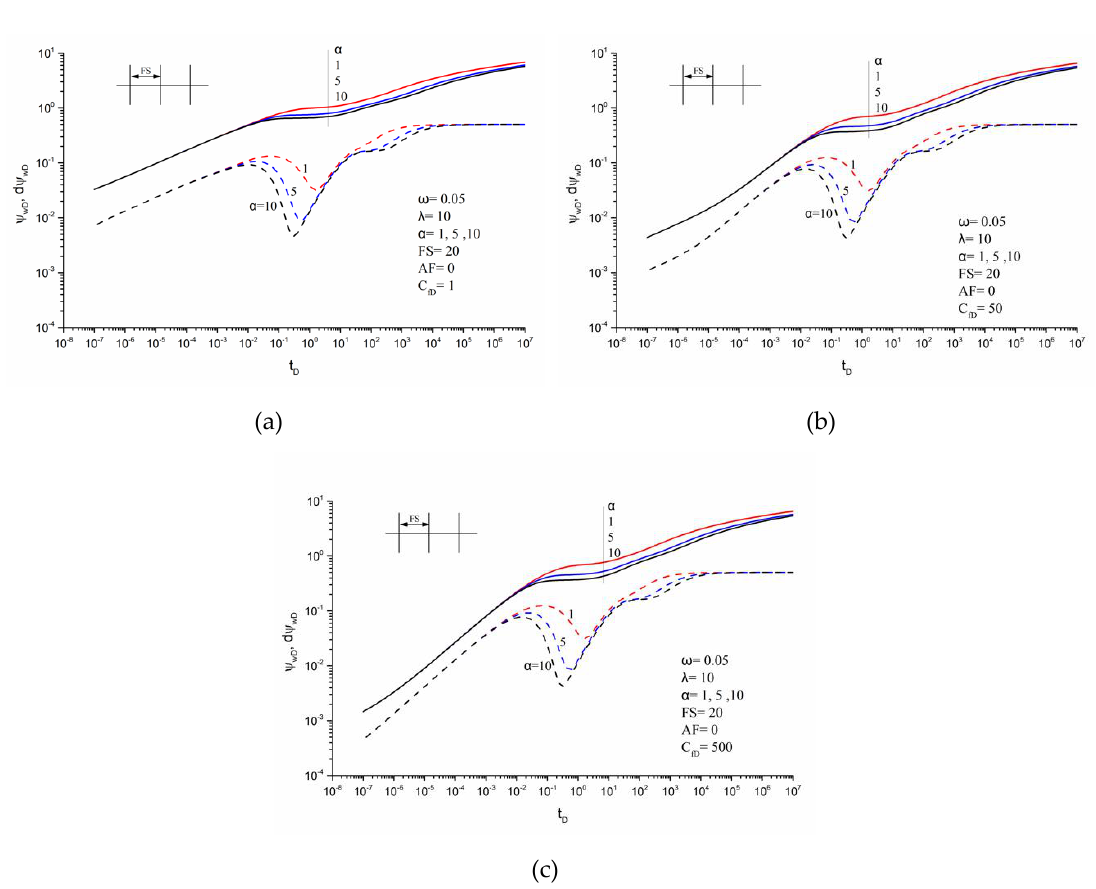
Figure 9. The typical pseudo-pressure curves of a multi-fractured horizontal well with different adsorption index. (a) Low conductivity; (b) intermediate conductivity; (c) high conductivity.